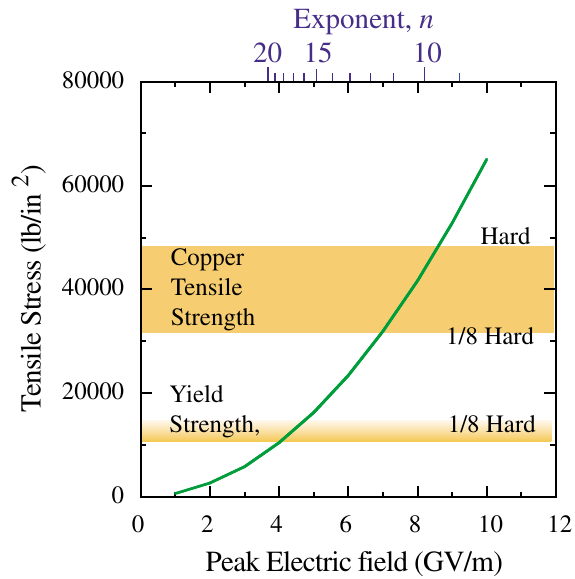
FIG. 35. (Color) Stress at emitters as a function of local field E and the exponent n .